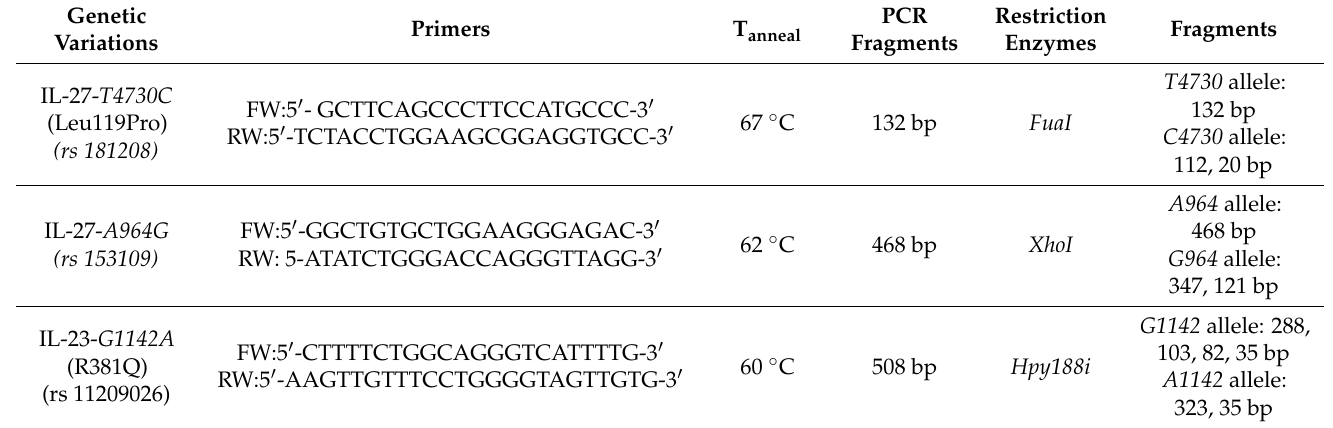
Table 1. PCR and RFLP conditions for IL-27 and IL-23 polymorphism